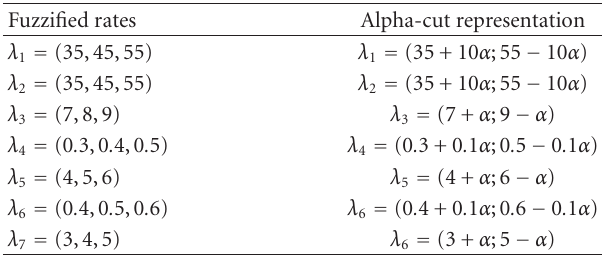
Table 12: Fuzzified transitions firing rates with their alpha cuts. Fuzzified rates